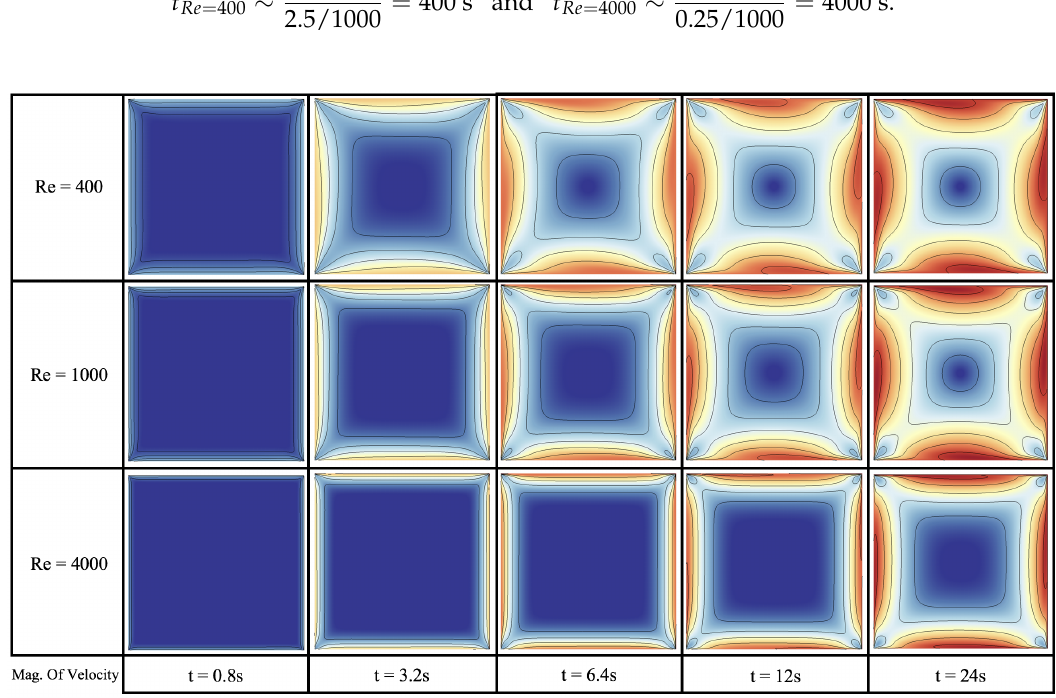
Figure 25. Snapshots showing the evolution of the magnitude of velocity between cases of Re = 400,1000, and